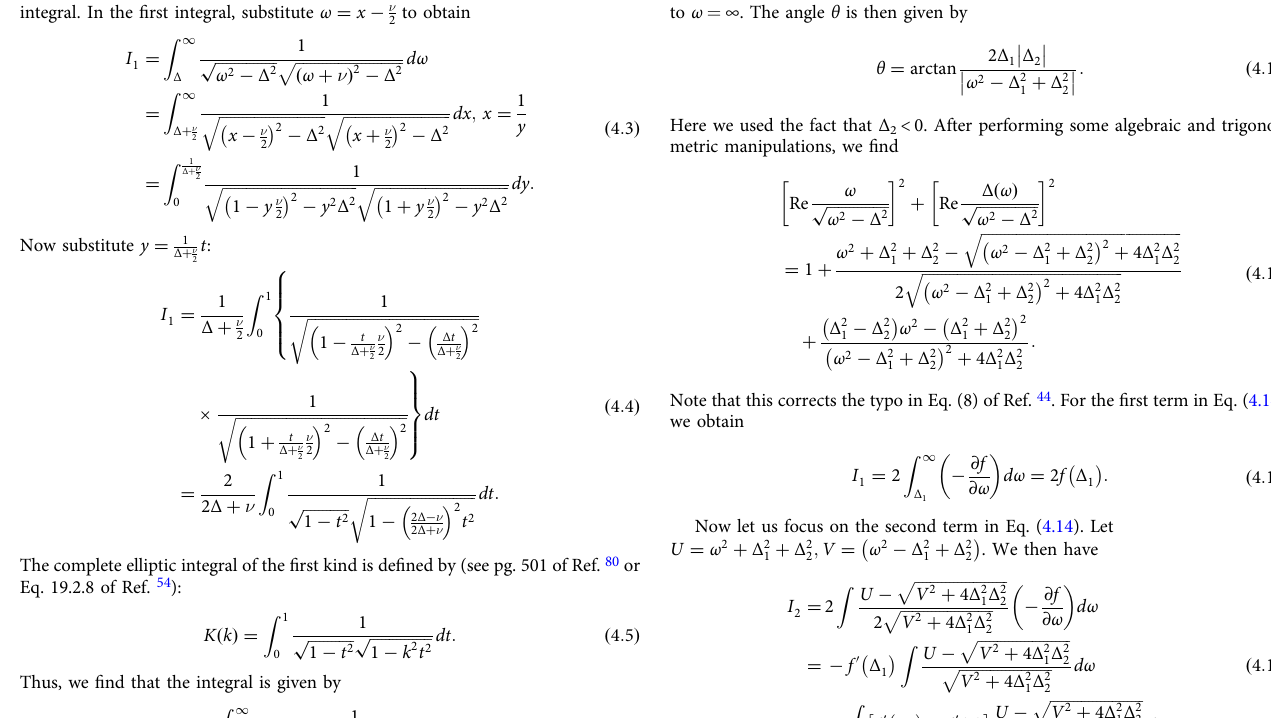
ffiffiffiffiffiffiffiffiffiffiffiffiffiffiffiffiffiffiffiffiffiffiffiffi p (cid:5) U (cid:1) V 2 þ 4 Δ 2 1 Δ 2 2 ffiffiffiffiffiffiffiffiffiffiffiffiffiffiffiffiffiffiffiffiffiffiffiffi